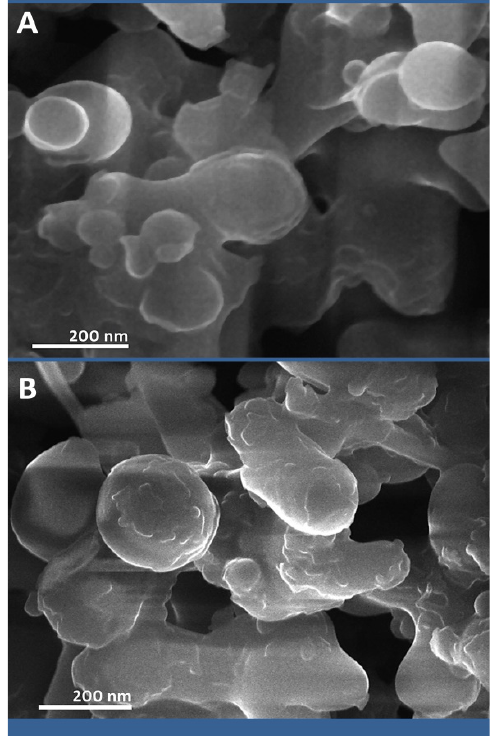
Figure 2. Scanning microscopy imaging of ( A ): synthesized nanochitosan and ( B ): its conjugates with shilajit water extract.